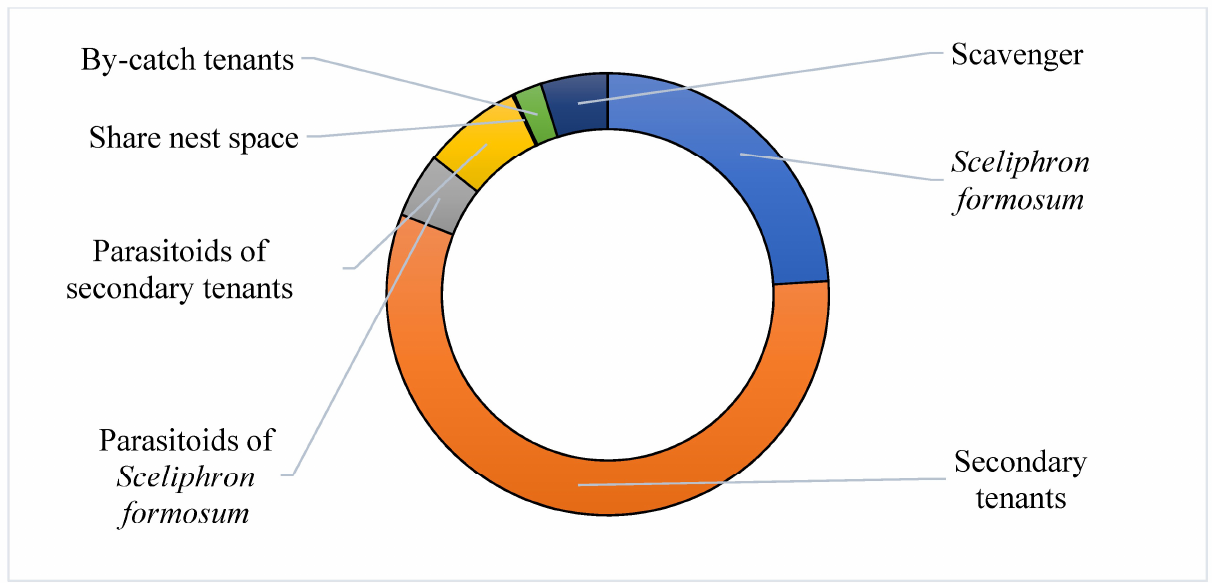
Figure 5. Percentage of Sceliphron formosum nests occupied by seven groups of insect tenants (n = 655): 1. Nest builder: Sceliphron formosum (24.7%) 2. Secondary tenants (58.6%) 3. Parasitoids of nest builders (4.8%) 4. Parasitoids of secondary tenants (7.4%) 5. Invader that shares the mud nest (0.1%) 6. By-catch tenants (2.1%) 7. Scavenger